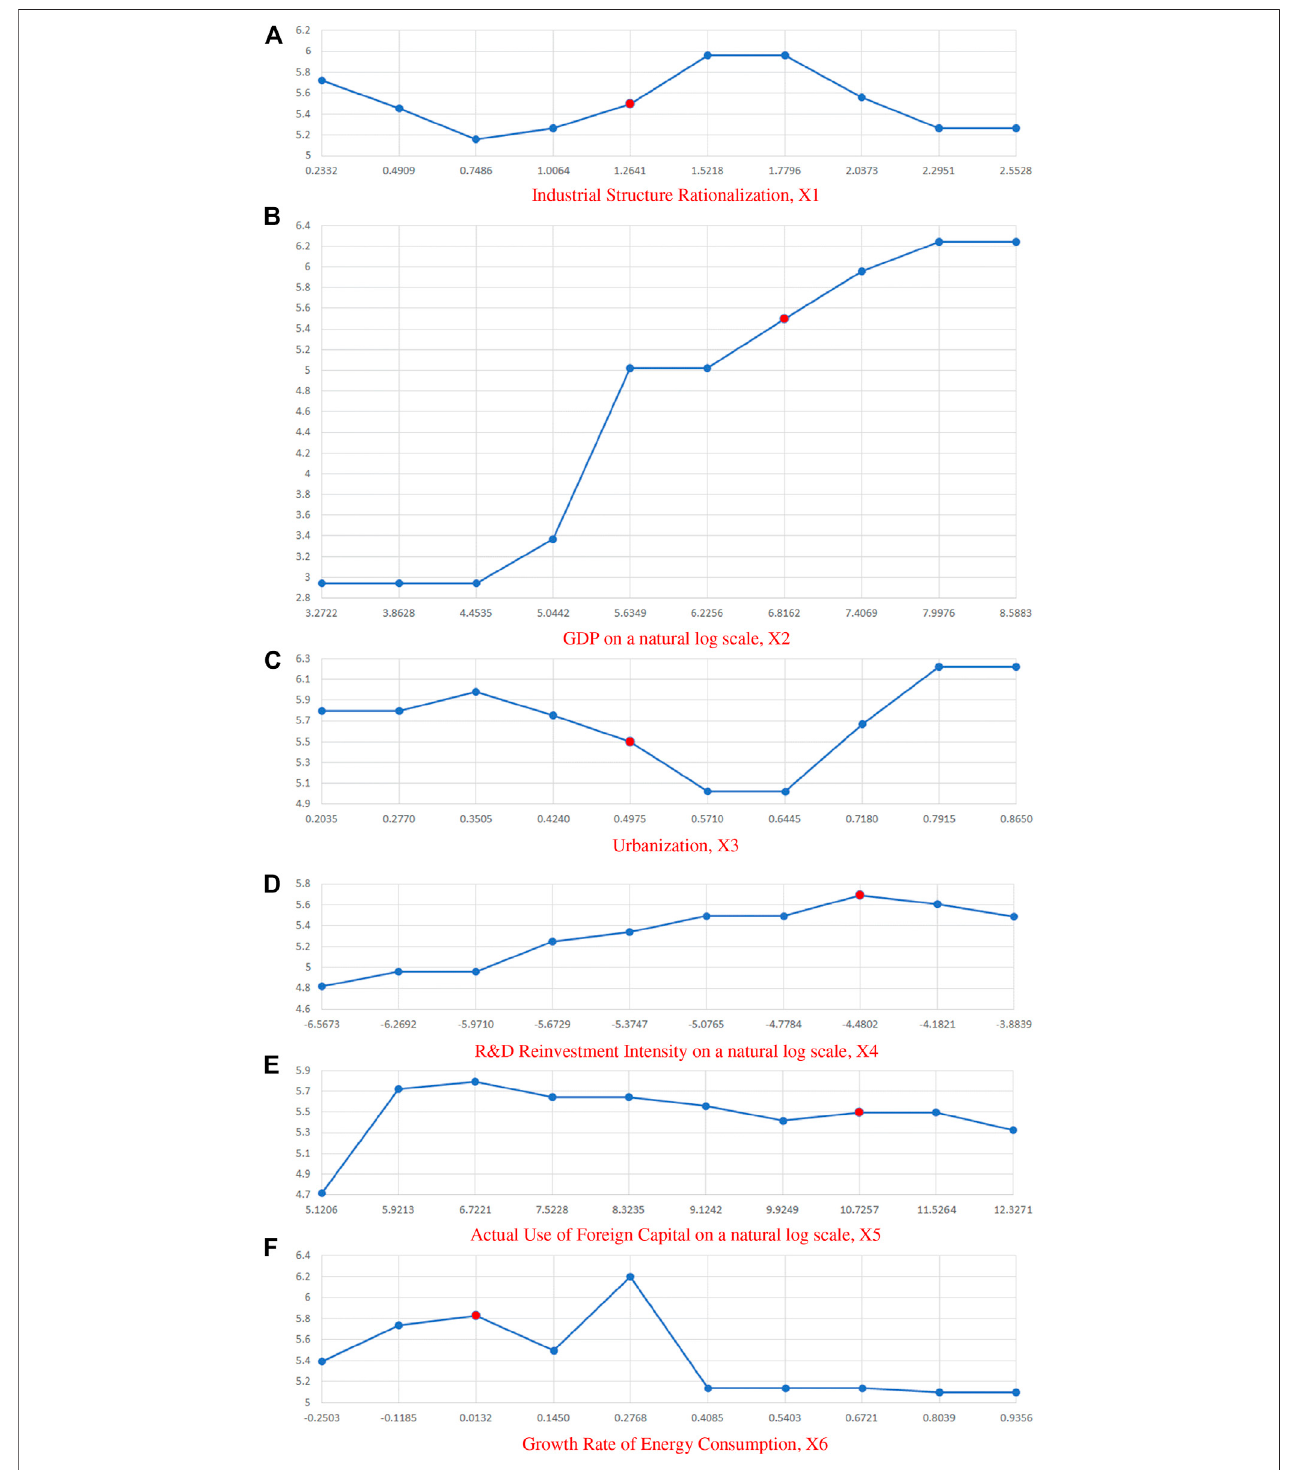
FIGURE 11 | Sensitivity analysis of variables around the centroid of KNN (2). represents the centroid of the data ‒ the most populated bin of the data Only one variable varies while keeping the other variables unchanged at centroid values.